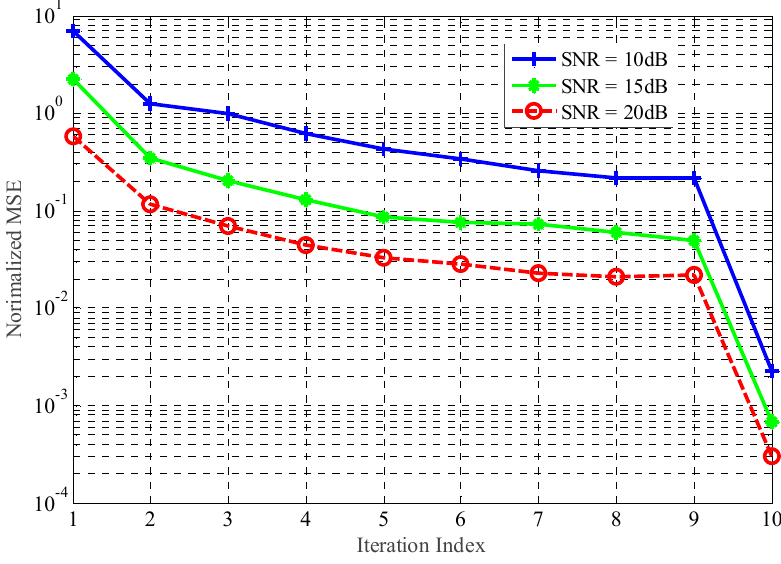
Figure 5. The estimation performance with different SNR.